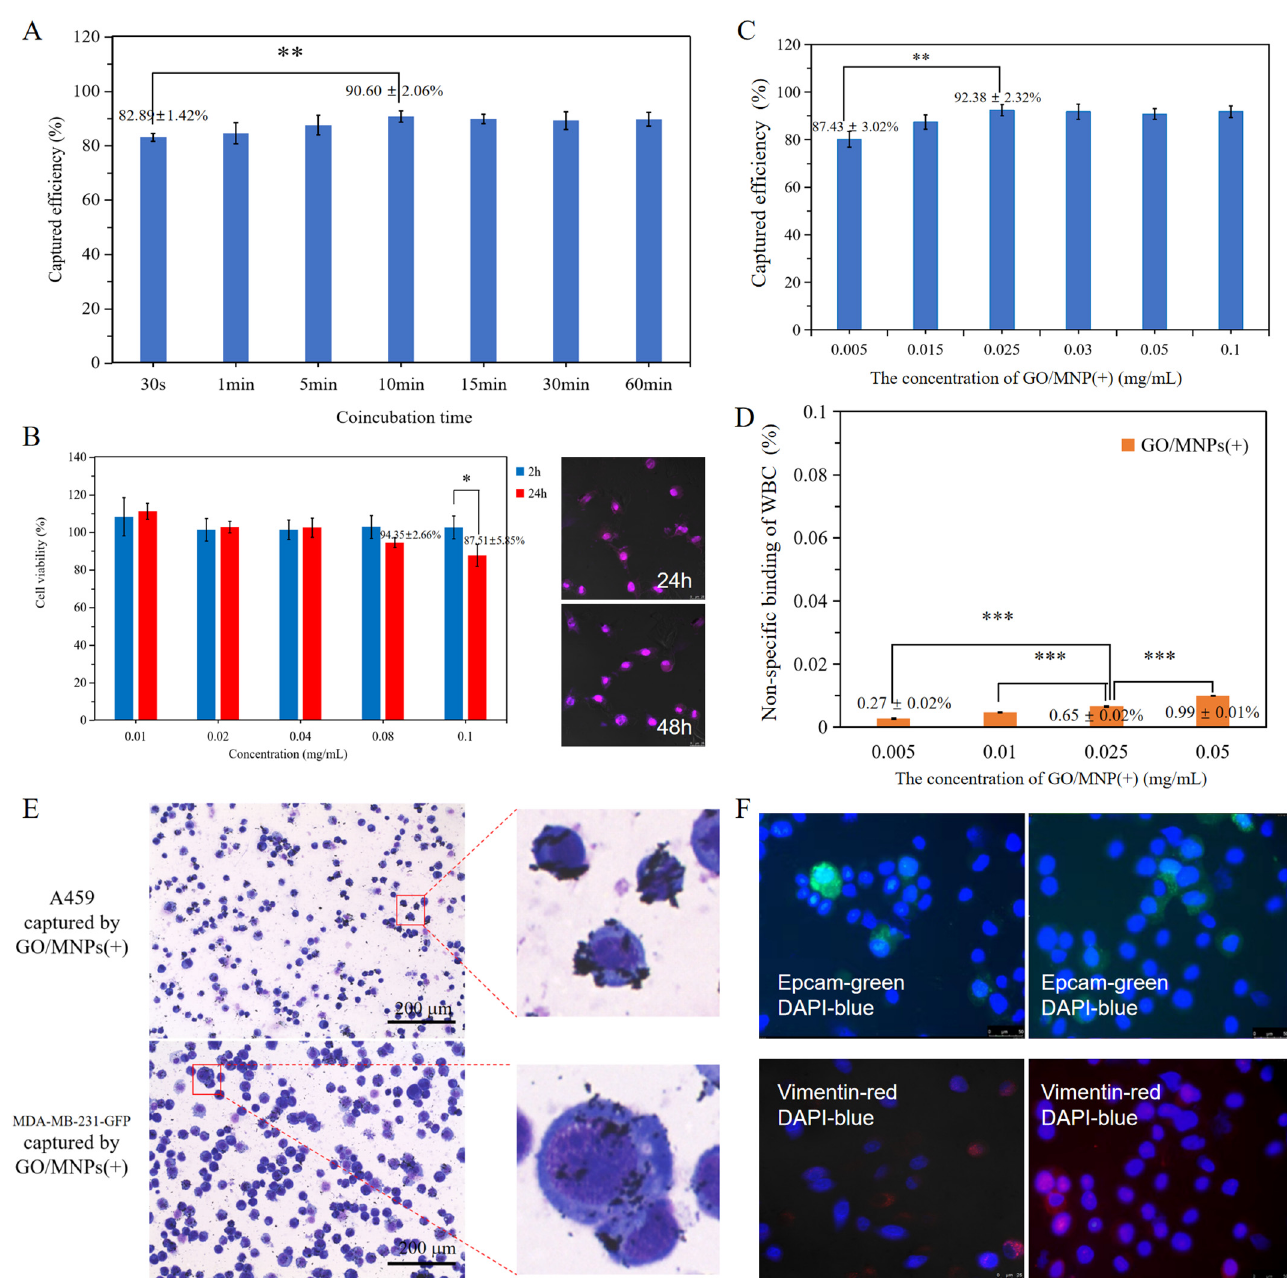
Figure 5. Principle scalability of the charged nanoprobe detection platform based on tumor cell electrophysiological characteristics. ( A ) detection speed, the capture efficiency of GO/MNPs(+) on A549 cells under different co-incubation time conditions (SD, n = 3, t -test: p < 0.01 **); ( B ) biosafety and reculture, cell viability of A549 cells co-cultured with GO/MNPs(+) at different concentrations for 2 h and 24 h (SD, n = 5, t -test: p < 0.05 *), and captured cells activity at 24 h and 48 h; ( C ) nanoprobe usage and capture efficency, capture efficiency of A549 cells at different concentrations of GO/MNPs(+) (SD, n = 3, t -test: p < 0.01 **); ( D ) detection specificity, nonspecific targeting efficiency of the combination of nanoprobes and white blood cells (WBC) (SD, n = 3, t -test: p < 0.001 ***); ( E ) The cancer cells with different physical sizes were captured by GO/MNPs(+) (bar = 200 um); ( F ) identification by immunofluorescence of epithelial and mesenchymal cancer cells captured by GO/MNPs(+).